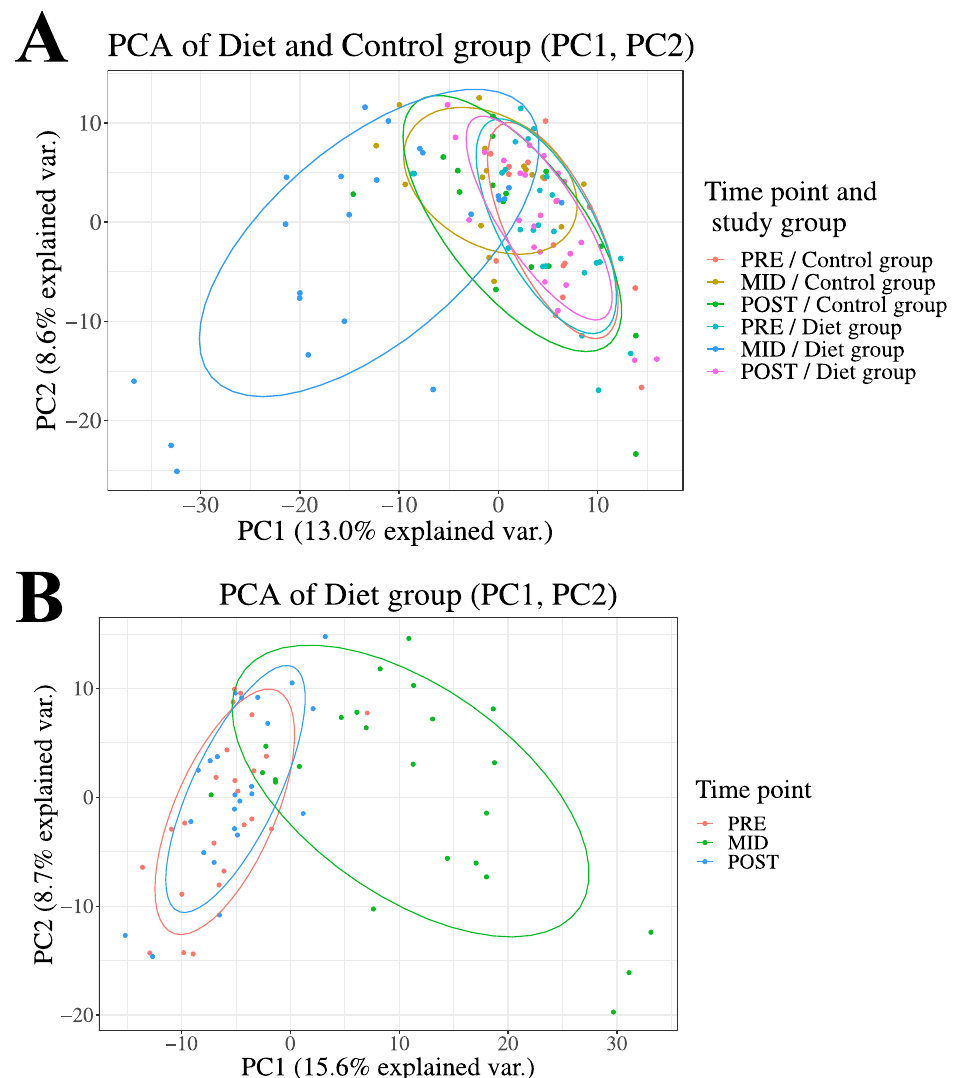
Figure 2. Principal Component Analysis (PCA) of the LC-MS metabolome. Here, we demonstrate overall changes in how the prolonged period of low-energy availability and high volume of exercise training led to substantial fat mass loss (PRE-MID) and subsequent weight regain period (MID-POST) modulated plasma LC-MS metabolome profile (684 metabolite features) in the diet group when compared to controls Panel ( A ). Control group variation during the entire study period (PRE-MID-POST) depicted in two-dimensional PCA plot Panel ( A ). The group and time point annotation is as follows: (1) red = diet group (PRE), (2) green = diet group (MID), (3) blue = diet group (POST), (4) yellow = control group (PRE), (5) turquoise = control group (MID), (6) pink = control group (POST). In panel ( B ), only the diet group-associated changes are demonstrated for clarity of interpretation.